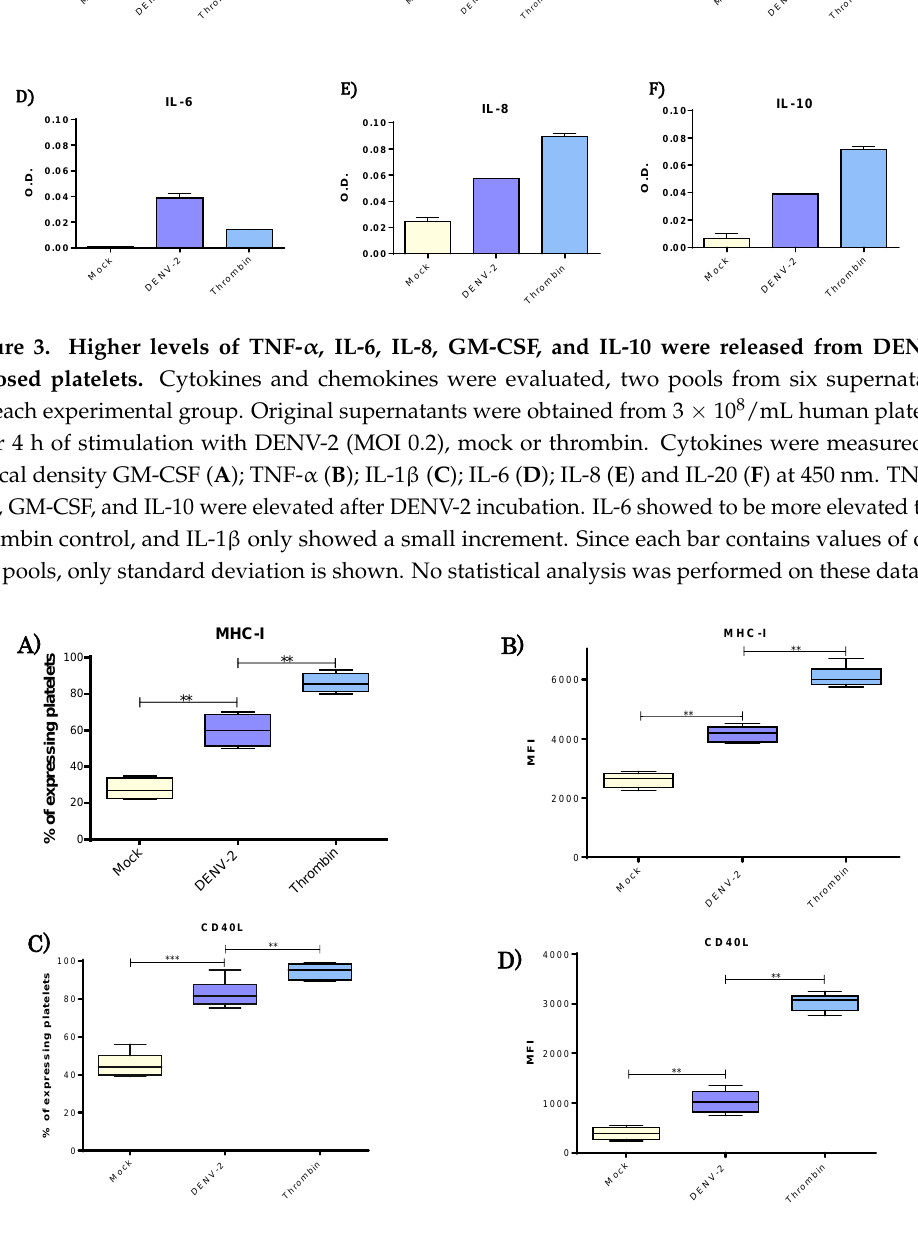
Figure 4. DENV-2 induced an increase of MHC-I and CD40L molecules on platelets. Platelets were obtained from healthy donors ( n = 10) and divided in the three experimental groups. Platelets, DENV-2, and MOI 0.5 were incubated for 4 h at 37 ◦ C; mock and thrombin groups were also processed. Percentage of MHC-I expressing platelets ( A ) and MFI of MHC-I ( B ) were determined. Additionally; percentage of platelets expression CD40L ( C ); and MFI in platelets of CD40L ( D ) were evaluated. Significant increases of MHC class I and CD40L were observed in the DENV-2 treated platelets for both percentages and density of molecules in the cell surface. Unpaired t test and Mann-Whitney U distribution were used, where ** p < 0.01 and *** p <